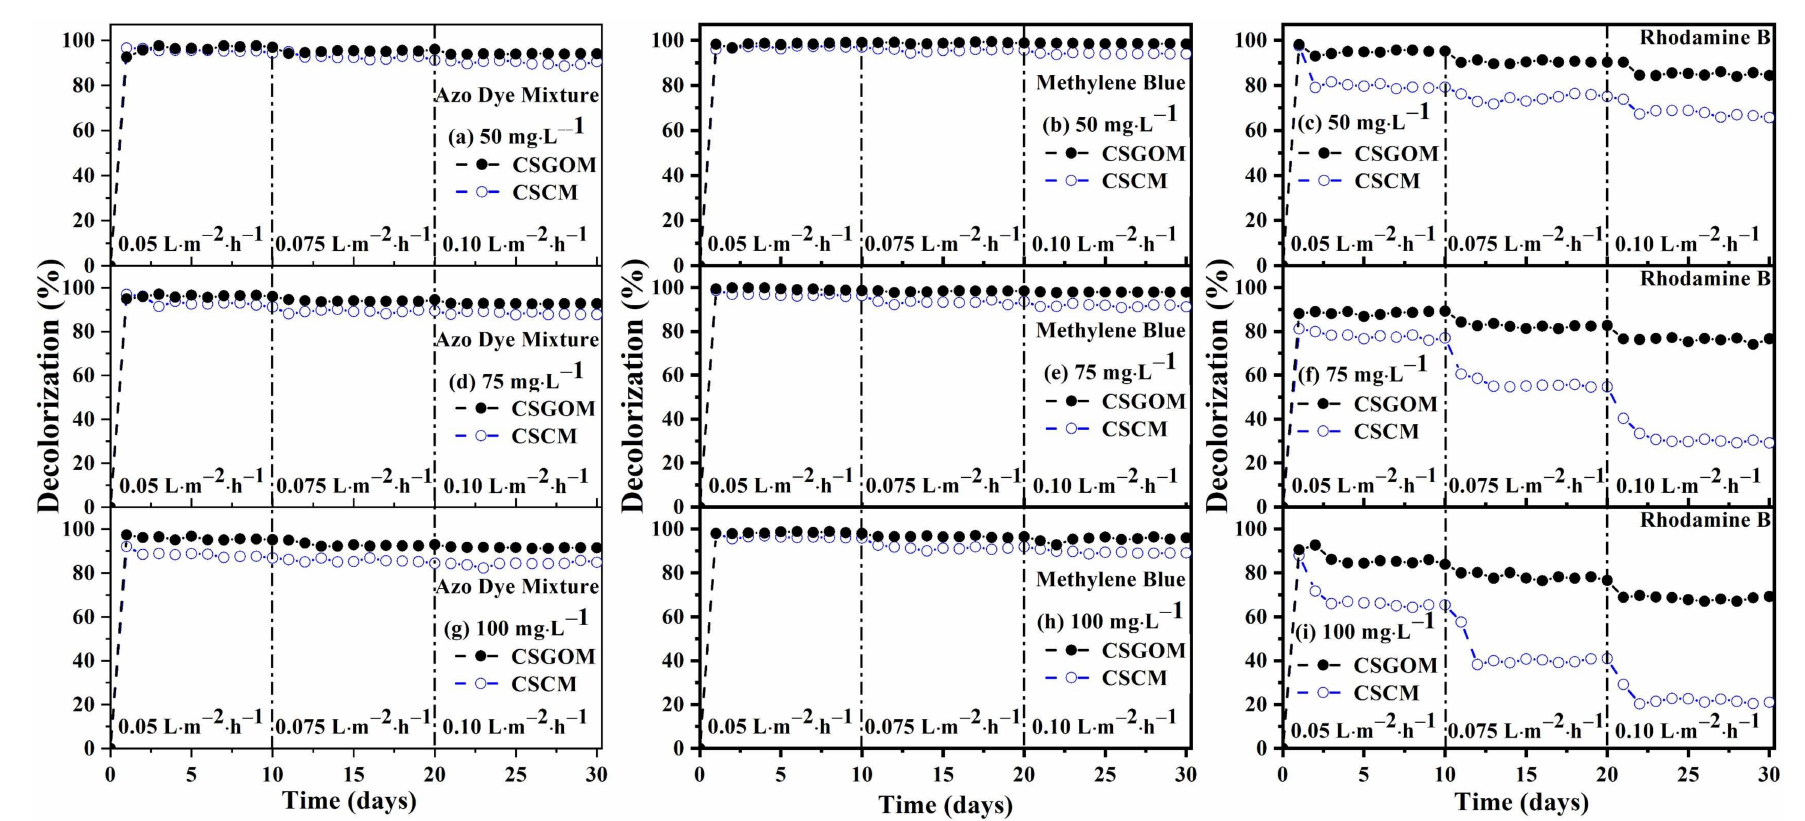
Figure 8. Anaerobic decolorization of the Azo dye mixture, Methylene Blue, and Rhodamine B dyes at various concentrations and fluxes; ( a – c ) 50 mg · L − 1